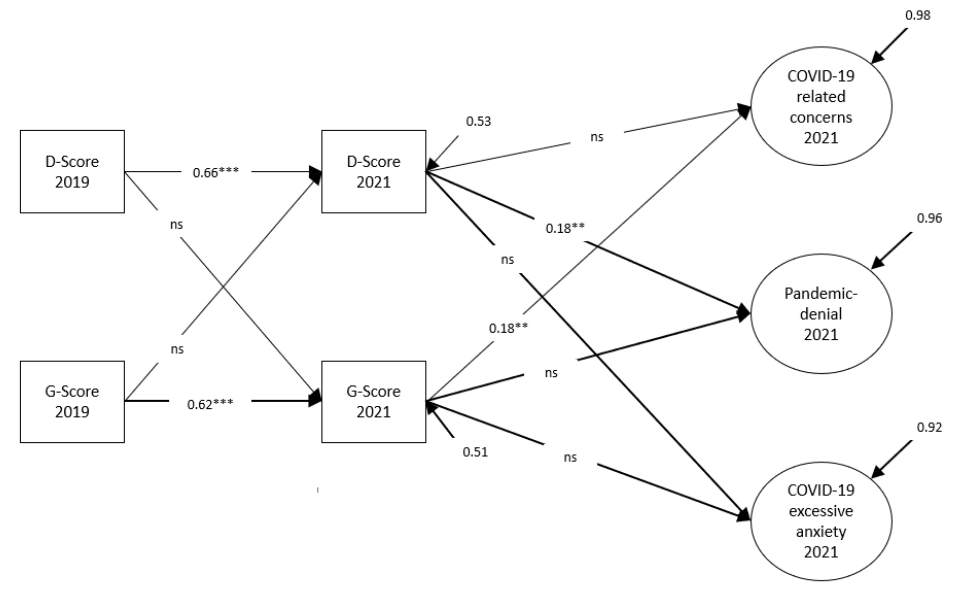
Figure 2. Cross-lagged model to explain COVID-19 attitudes (standardized solution), MLR estimation. χ 2 = 117.925 (df = 78, p = 0.002), RMSEA = 0.038, CFI = 0.969, TLI = 0.959, SRMR = 0.046. **, *** significant at the 5% or 1% level. The measurement model of COVID-19 attitudes as well as (residual) correlations between the factors are not shown here. Observed variables are represented by rectangles and latent variables by circles. Direct effects are depicted by unidirectional arrows. Arrows without “emitting” variables represent the measurement error of the respective variable.